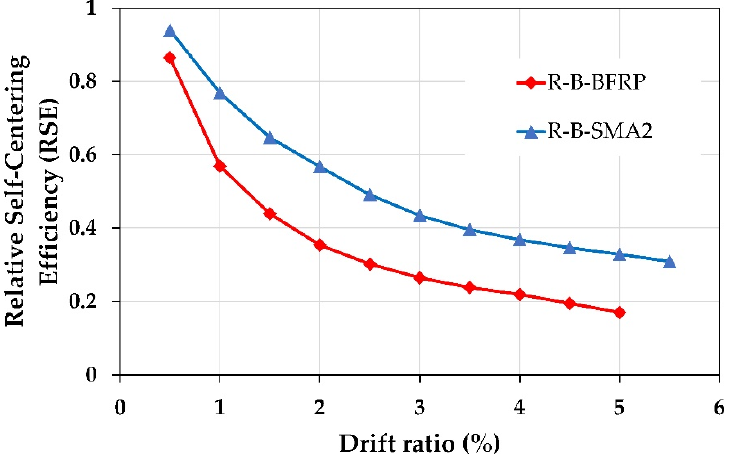
Figure 22. Relative self-centering efficiency of the columns R-B-SMA2 and R-B-BFRP.